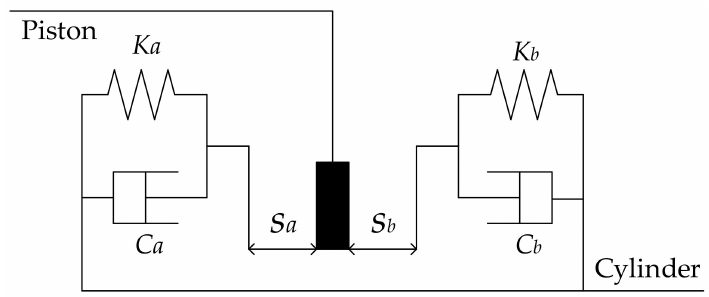
Figure 3. Schematic diagram of the cylinder motion